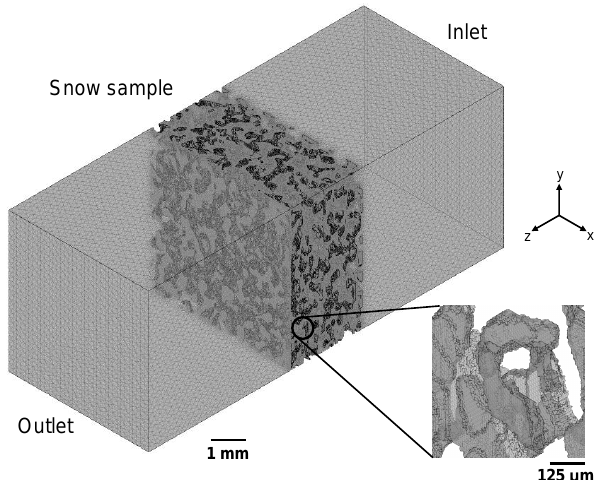
Figure 2. Schematic of the computational domain with an enlarged subsample of snow. In the snow sample, the dark gray part repre- sents the ice, whereas the mesh is built in the pore space.